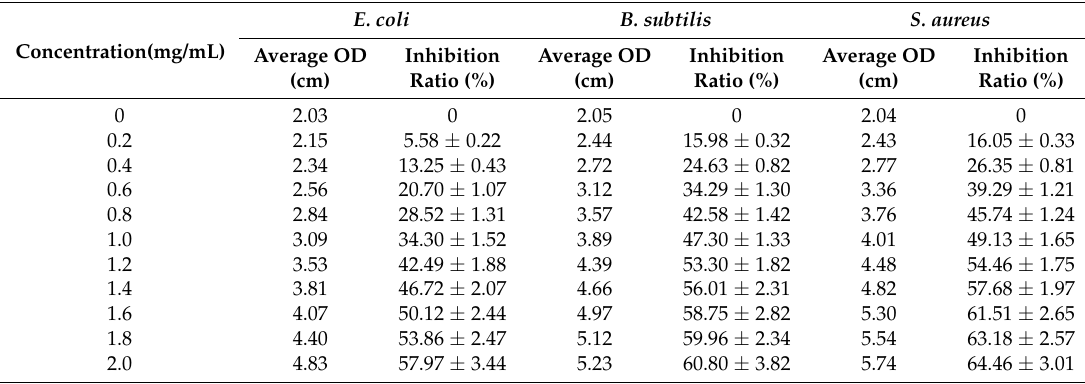
Table 4. Inhibition activities of essential oils on E. coli , B. subtilis , and S.